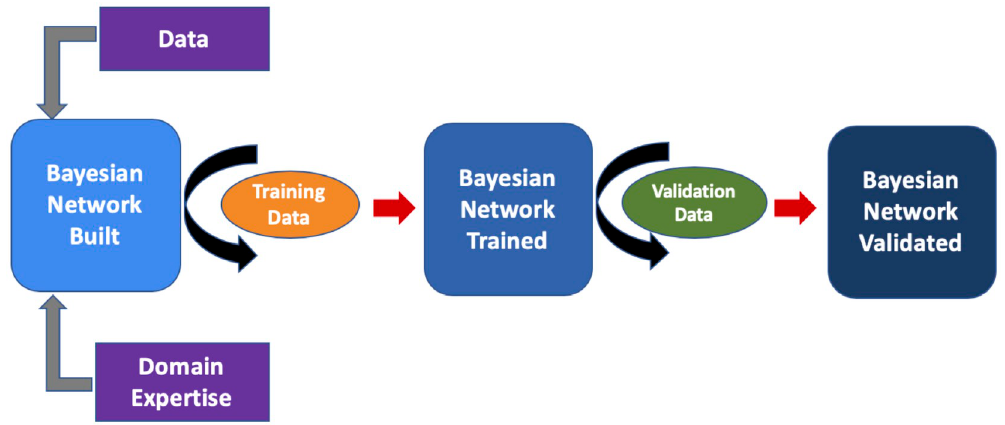
Fig 2. Analytics plan. Network construction, training and validation scheme. Here, 100 patients (50 PI and 50 Control) were used as training data and 150 (75 each cohort) were used as validation data.